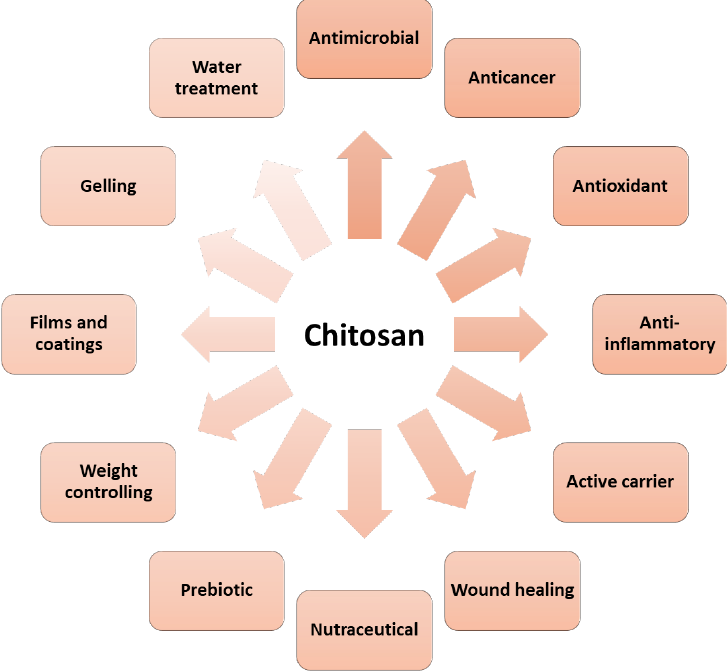
Figure 7. Diverse biological, functional and technological properties of chitosan. Chitin is composed by (1,4)- β -2-acetamido-2-deoxy-D-glucopyranose units and low amounts of (1,4)- β -2-amino-2-deoxy-D-glucopyranose units, whereas chitosan is com- posed of N-acetyl- D -glucosamine (A-units) and deacetylated D-glucosamine (D-units) units [98]. The main difference is that chitosan is deacetylated (Figure 8), which makes it soluble in mild acidic solutions, whereas chitin is insoluble in many organic and inorganic